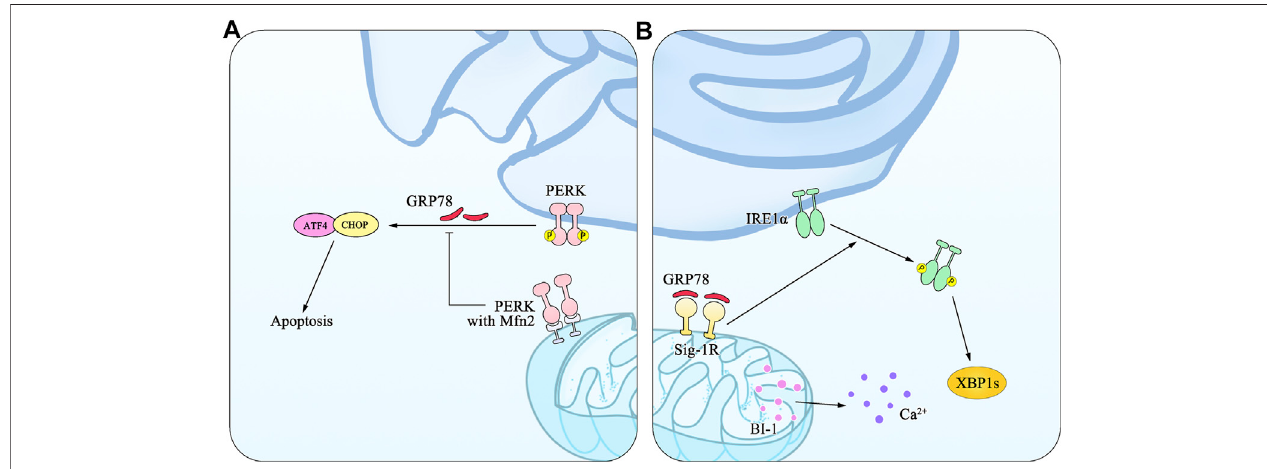
FIGURE 2 | An illustration of MAMs and mitochondrial dysfunction in ER stress. MAMs are the ER membranes at the MERCs, which form a stable bridge between theERmembraneandtheOMM,whosefusionismediatedbyMfn1,Mfn2,andSig-1R. (A) Mfn2isinvolvedinalterationsofmitochondrialmorphologythroughbindingto PERKand inhibitingPERKsignaling. (B) Asthelocalexpressionofchaperoneproteins, Sig-1/BiP activatestheIRE1/XBP1signaling pathwayviaIRE1dimerization.BI-1 resides on the MAMs and regulates mitochondrial Ca2+ concentration and apoptosis.